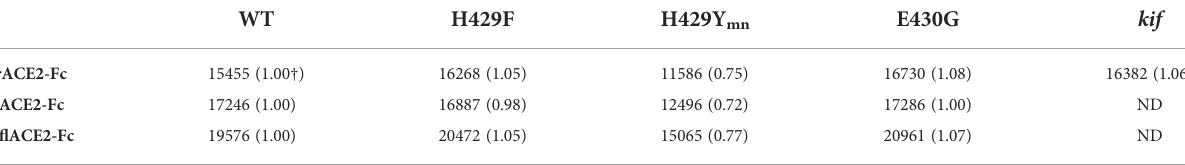
TABLE 2 Flow cytometric analysis of Ramos-S cells by opsonized ACE2-Fc proteins*. WT H429F H429Y mn kif